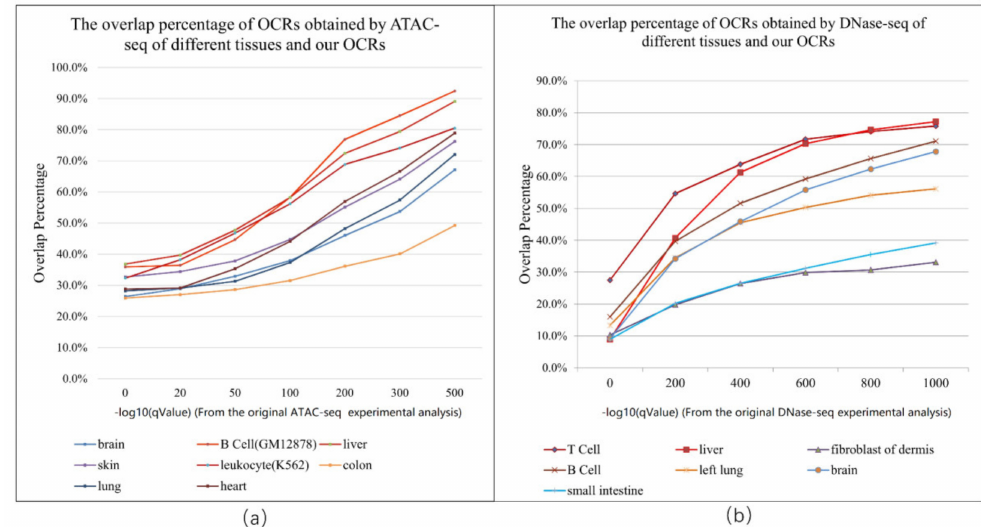
Figure 5. ( a ) The overlap percentage between the OCRs obtained by the ATAC-seq of different tissues and our OCRs. ( b ) The overlap percentage between the OCRs obtained by DNase-seq of different tissues and our OCRs. The x-axis of qValue , which is the measurement of statistical significance using the false discovery rate. The q-values ( a , b ) is the − log 10 come from the original ATAC-seq or DNase-seq experimental analyses. The y-axis is the percentage of DNase-seq or ATAC-seq credible regions that overlap with our